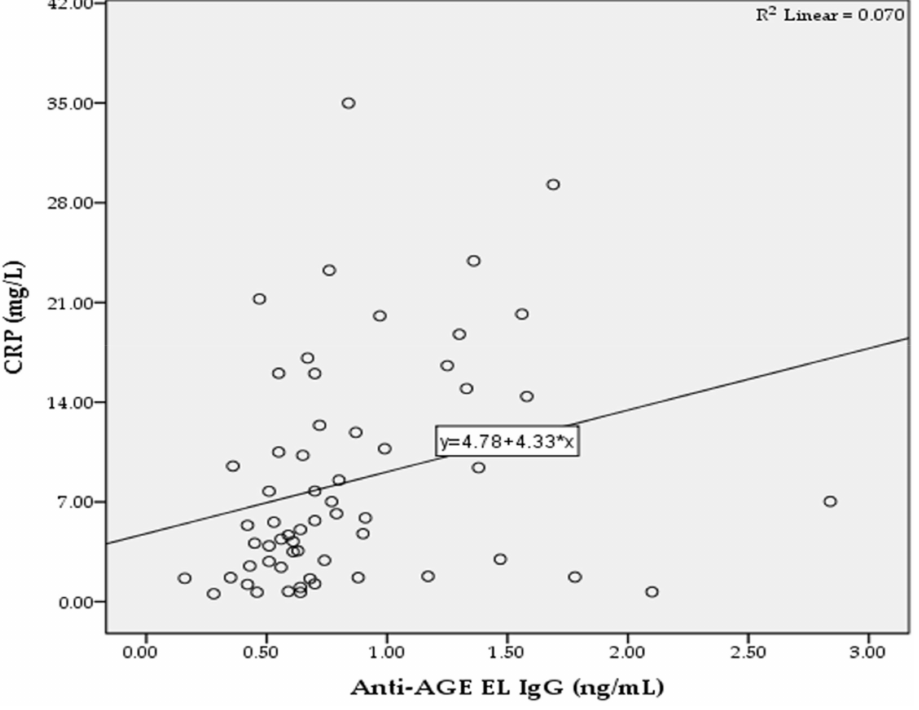
Figure 3. Correlation between the serum levels of anti-AGE EL IgG antibodies and CRP in the T2D